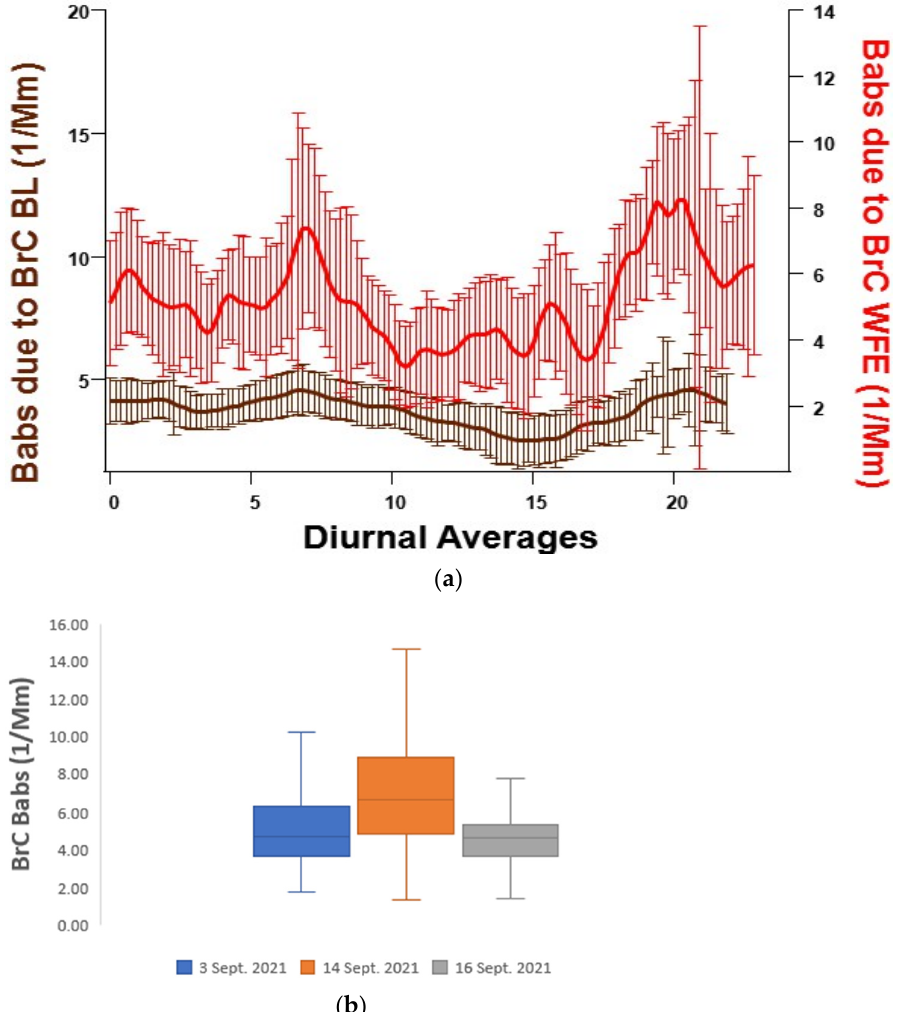
Figure 9. ( a ) The inferred BrC Babs is graphed here for the diurnal averages of 1 August through 23 September 2021. The Babs displayed in red are due to BrC corresponding to the eighteen event days (BrC Babs WFE), and displayed in black is the baseline (BL), BrC Babs driven by pollution from vehicular traffic. The graph has a smoothing filter applied). The error bars represent the standard error associated with each averaged point. ( b ) represents the spread of this data for three California wildfires event days.